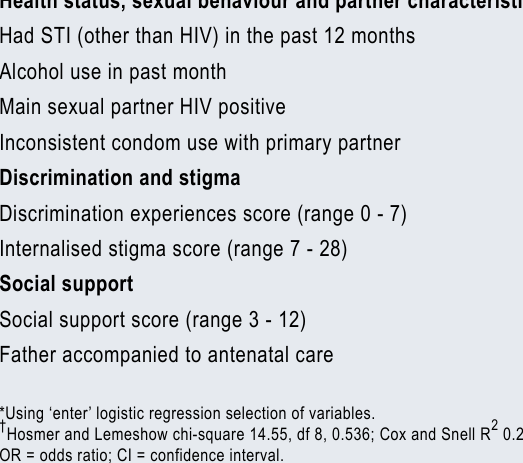
Had STI (other than HIV) in the past 12 months